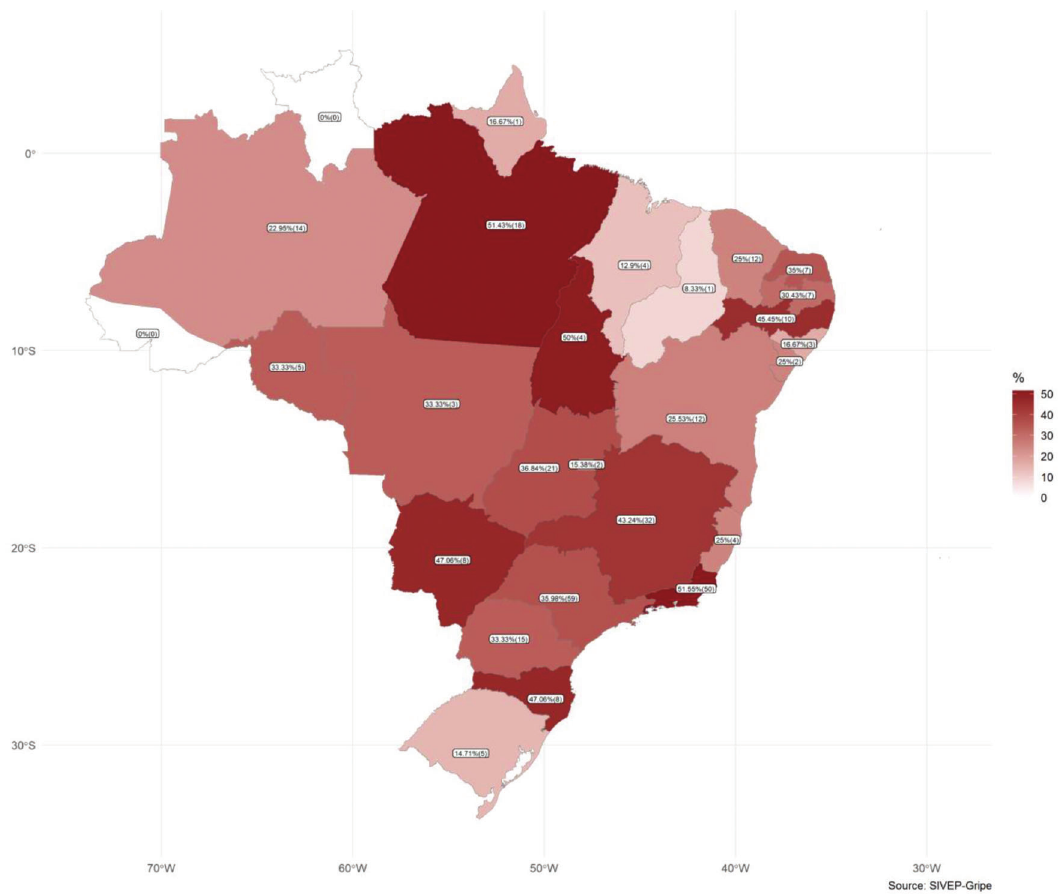
Figure 3 - Non-orotracheal intubation in deaths of pregnant and postpartum women with coronavirus disease